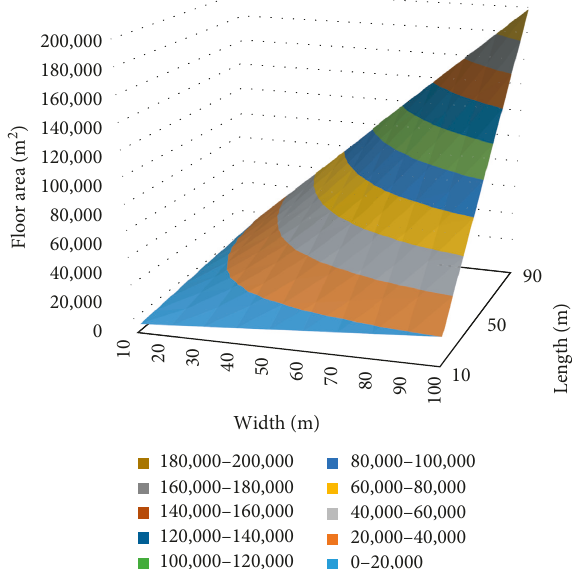
Figure 12: Energy consumption by mass scale (window area ratio 40%,